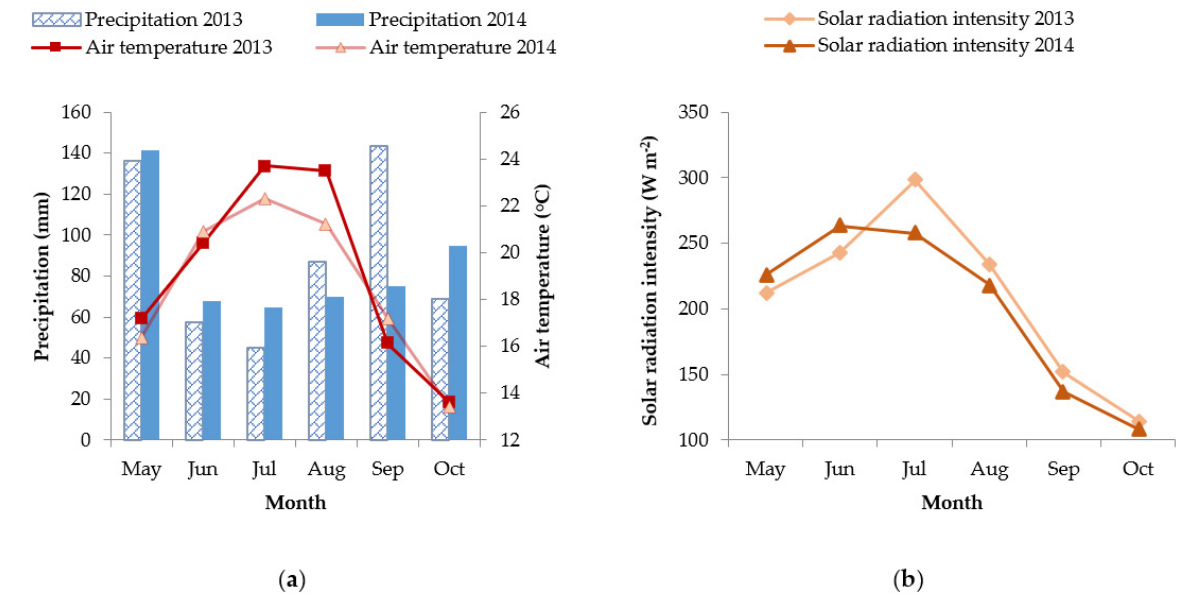
Figure 1. ( a ) Amount of precipitation (mm), mean air temperatures (°C), and ( b ) solar radiation intensity (W m − 2 ) in 2013 and 2014.